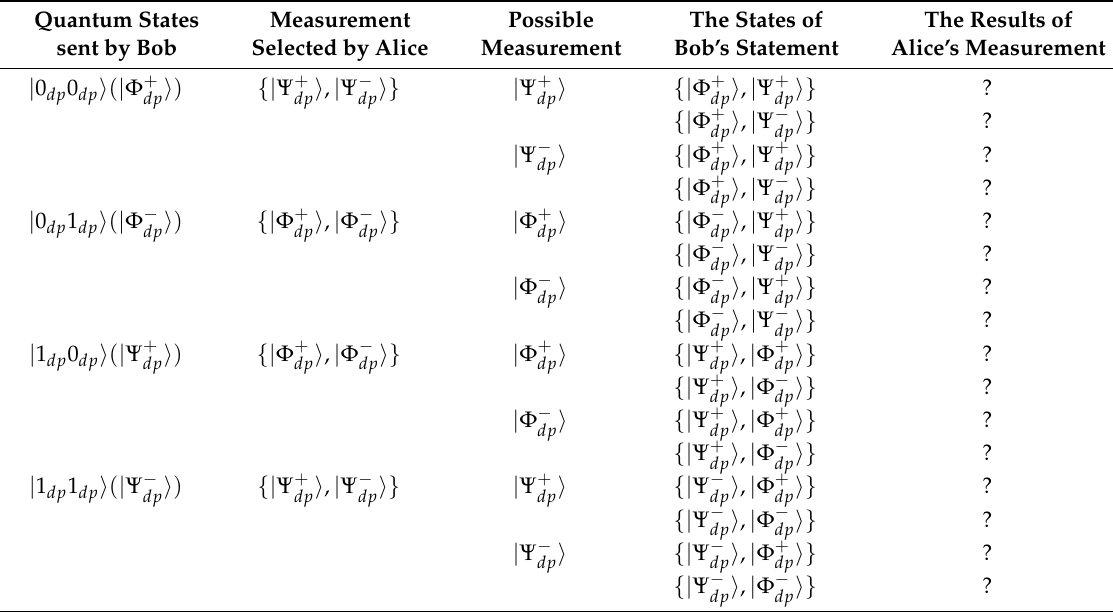
Table 3. Indeterminate